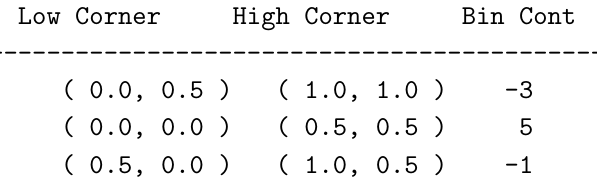
Figure 16 . Representation of the hyper-binning in (cid:12)gure 14 using the same format as hypbinning.txt